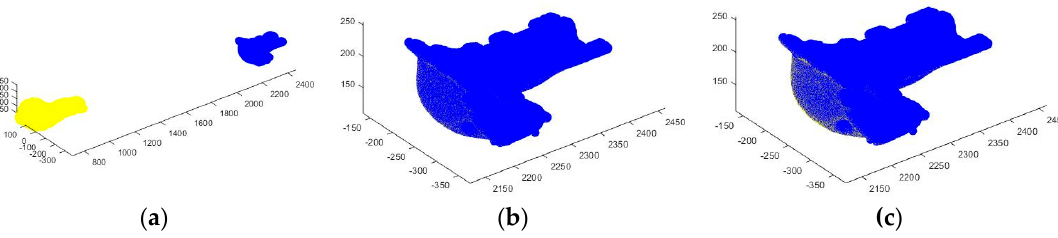
Figure 15. PCD after registration in Figure 10f. ( a ) is the initial position of the point cloud, ( b ) is the result of coarse registration, and ( c ) is the result of fine registration